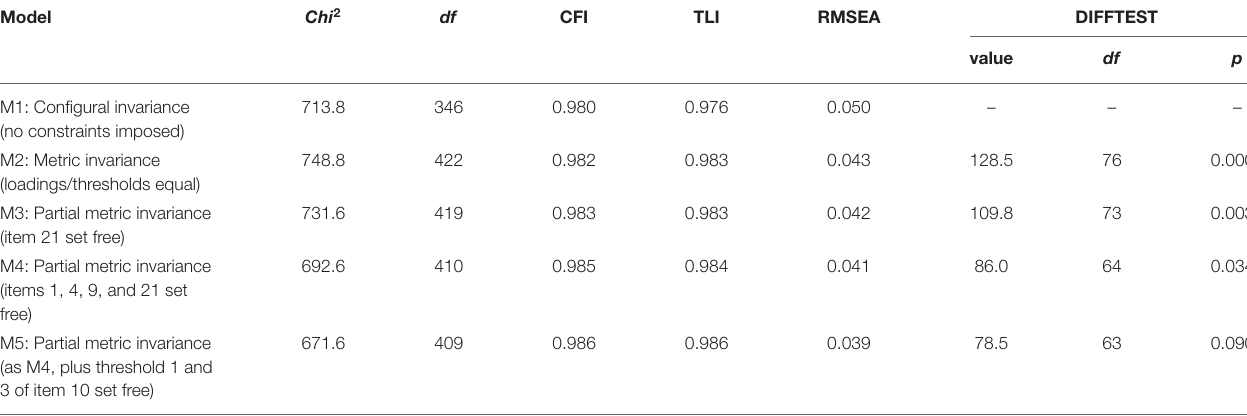
TABLE 7 | Model-fitting results from the measurement invariance tests across boys and girls based on the candidate bifactor model.